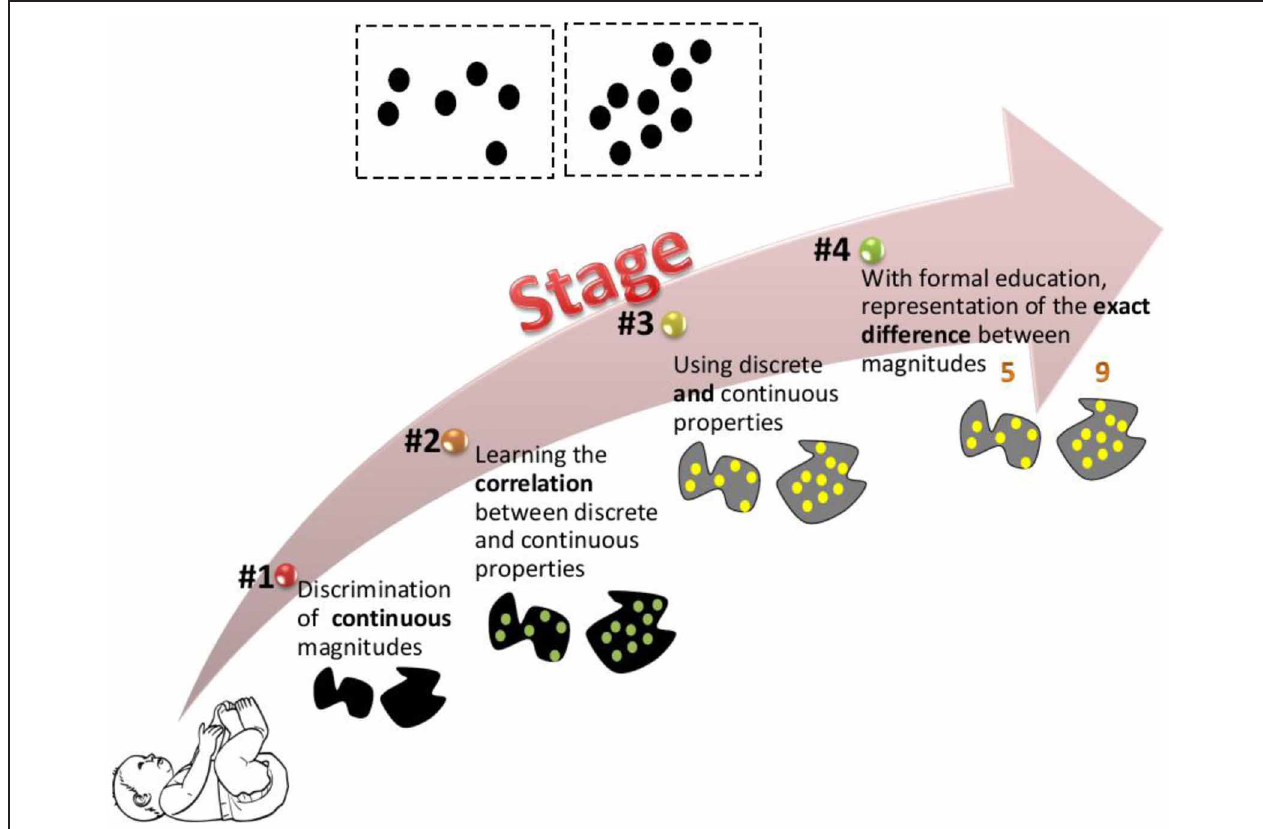
learn the correlation between discrete and continuous properties. This allows us to use both discrete and continuous properties to estimate magnitudes. Later, with formal education we are able to represent the exact difference between different